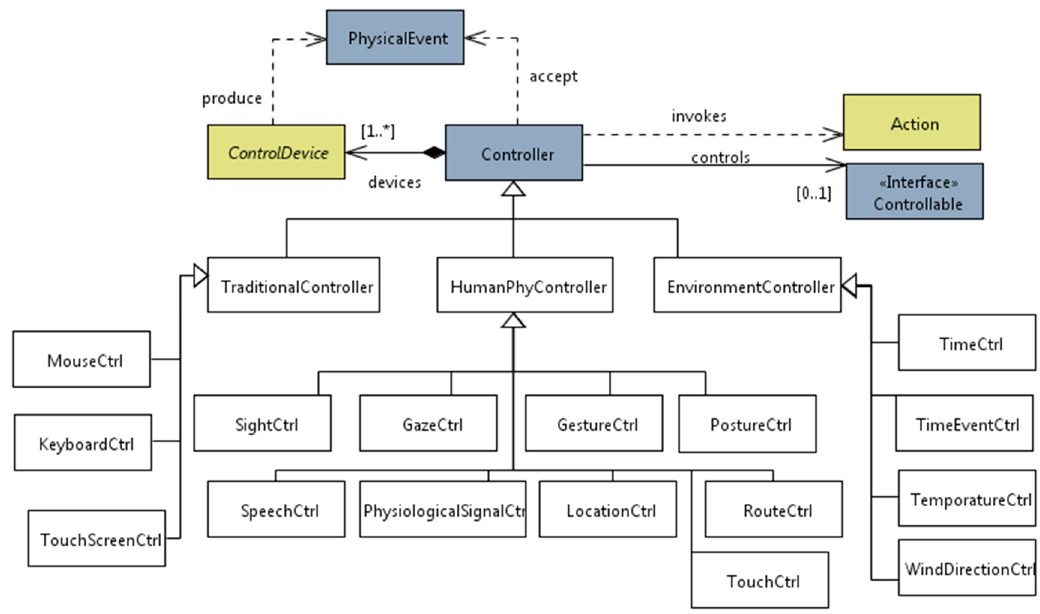
Figure 6. The pervasive game concepts in the control perspective.